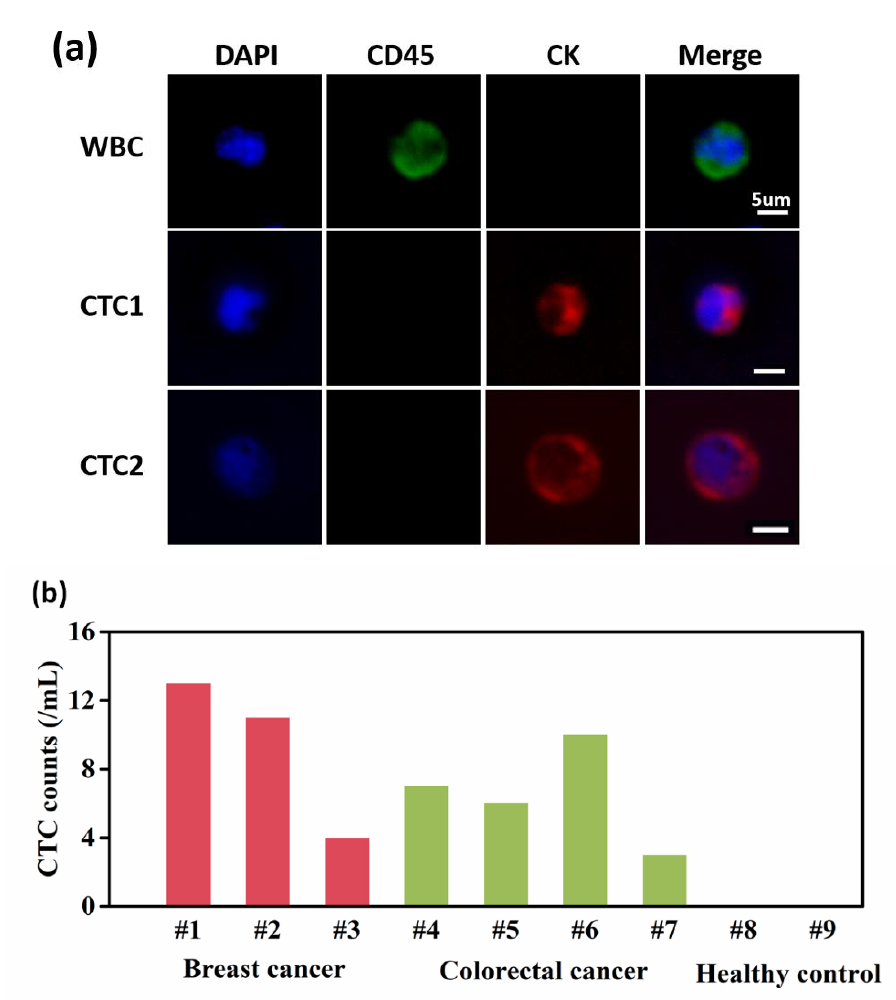
Figure 6. Identification of CTCs from 7 advanced cancer patients’ blood samples and 2 healthy donors’ blood samples. ( a ) Three color immunofluorescent micrographs (DAPI, FITC l-anti-CD45, PE-anti-CK) of WBCs and CTCs. ( b ) Number of CTCs from cancer patients’ blood samples and healthy donors’ blood samples .